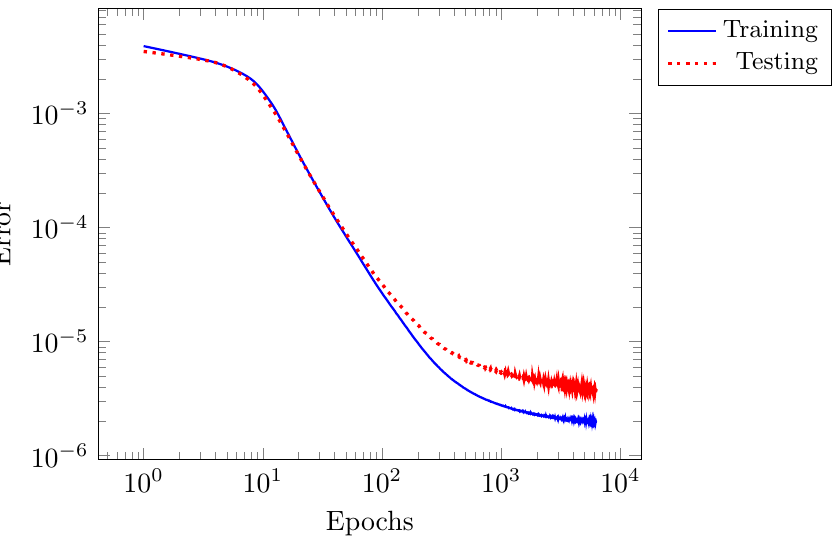
Figure 13. Behavior of the training and testing errors for the 1995 neurons, one-hidden-layer